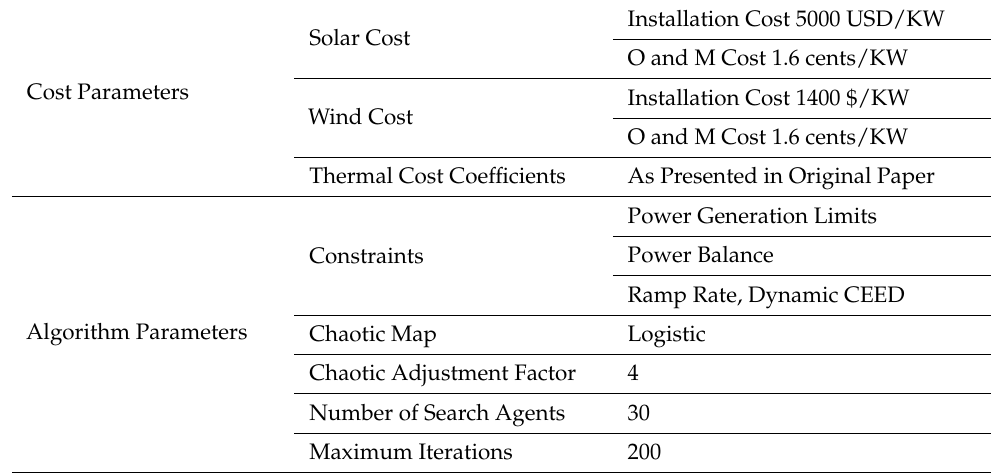
Table 2. Algorithm parameters, constraints, and renewable data—case study 1.